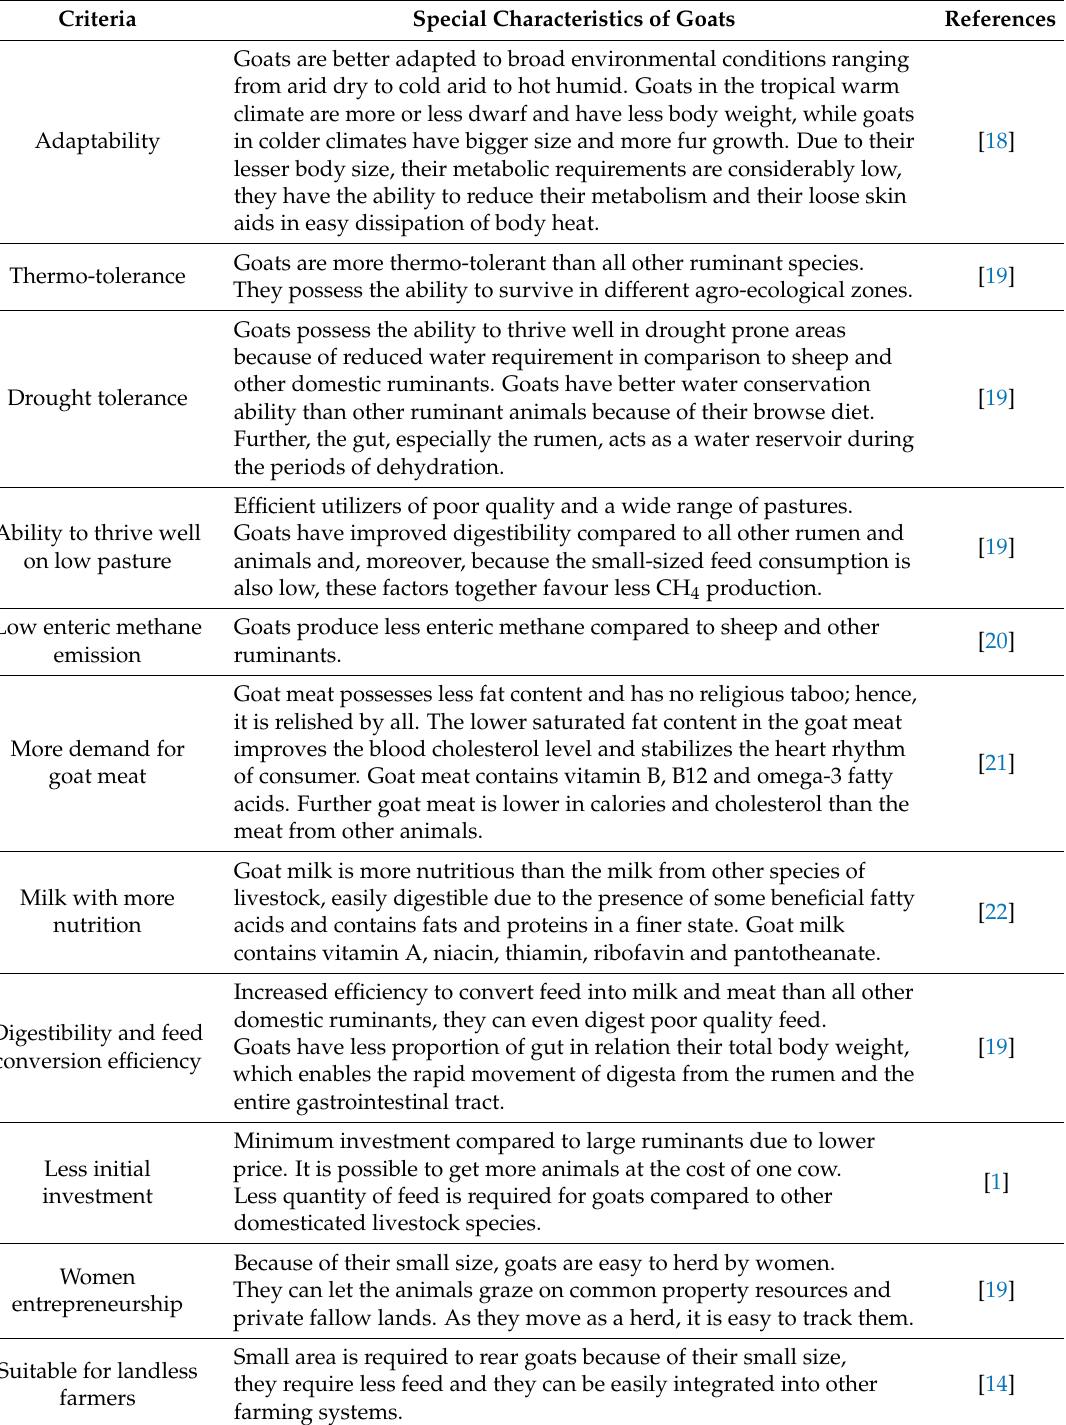
Table 1. Advantageous characteristics associated with goats over other livestock species to survive in harsh climatic